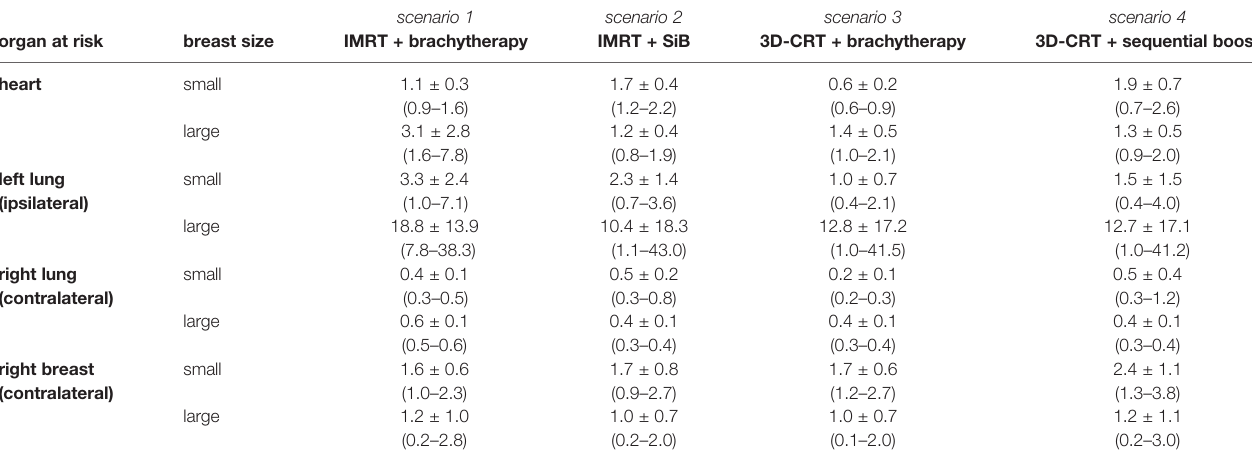
TABLE 3 | Dose exposure for the complete radiotherapy regime as shown in Figure 6 .